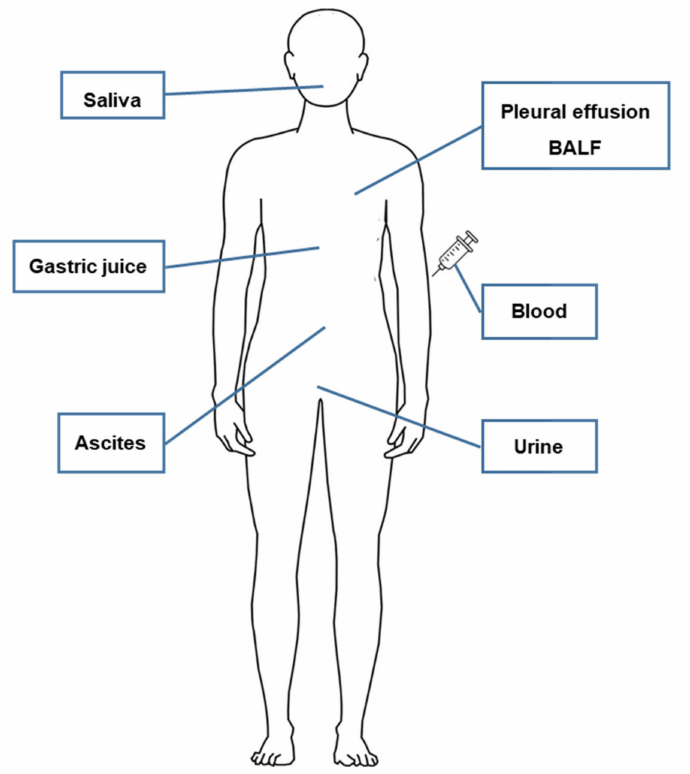
Figure 3. Body fluids as a source of DNA derived from EV. EV—extracellular vesicle; BALF— bronchoalveolar lavage